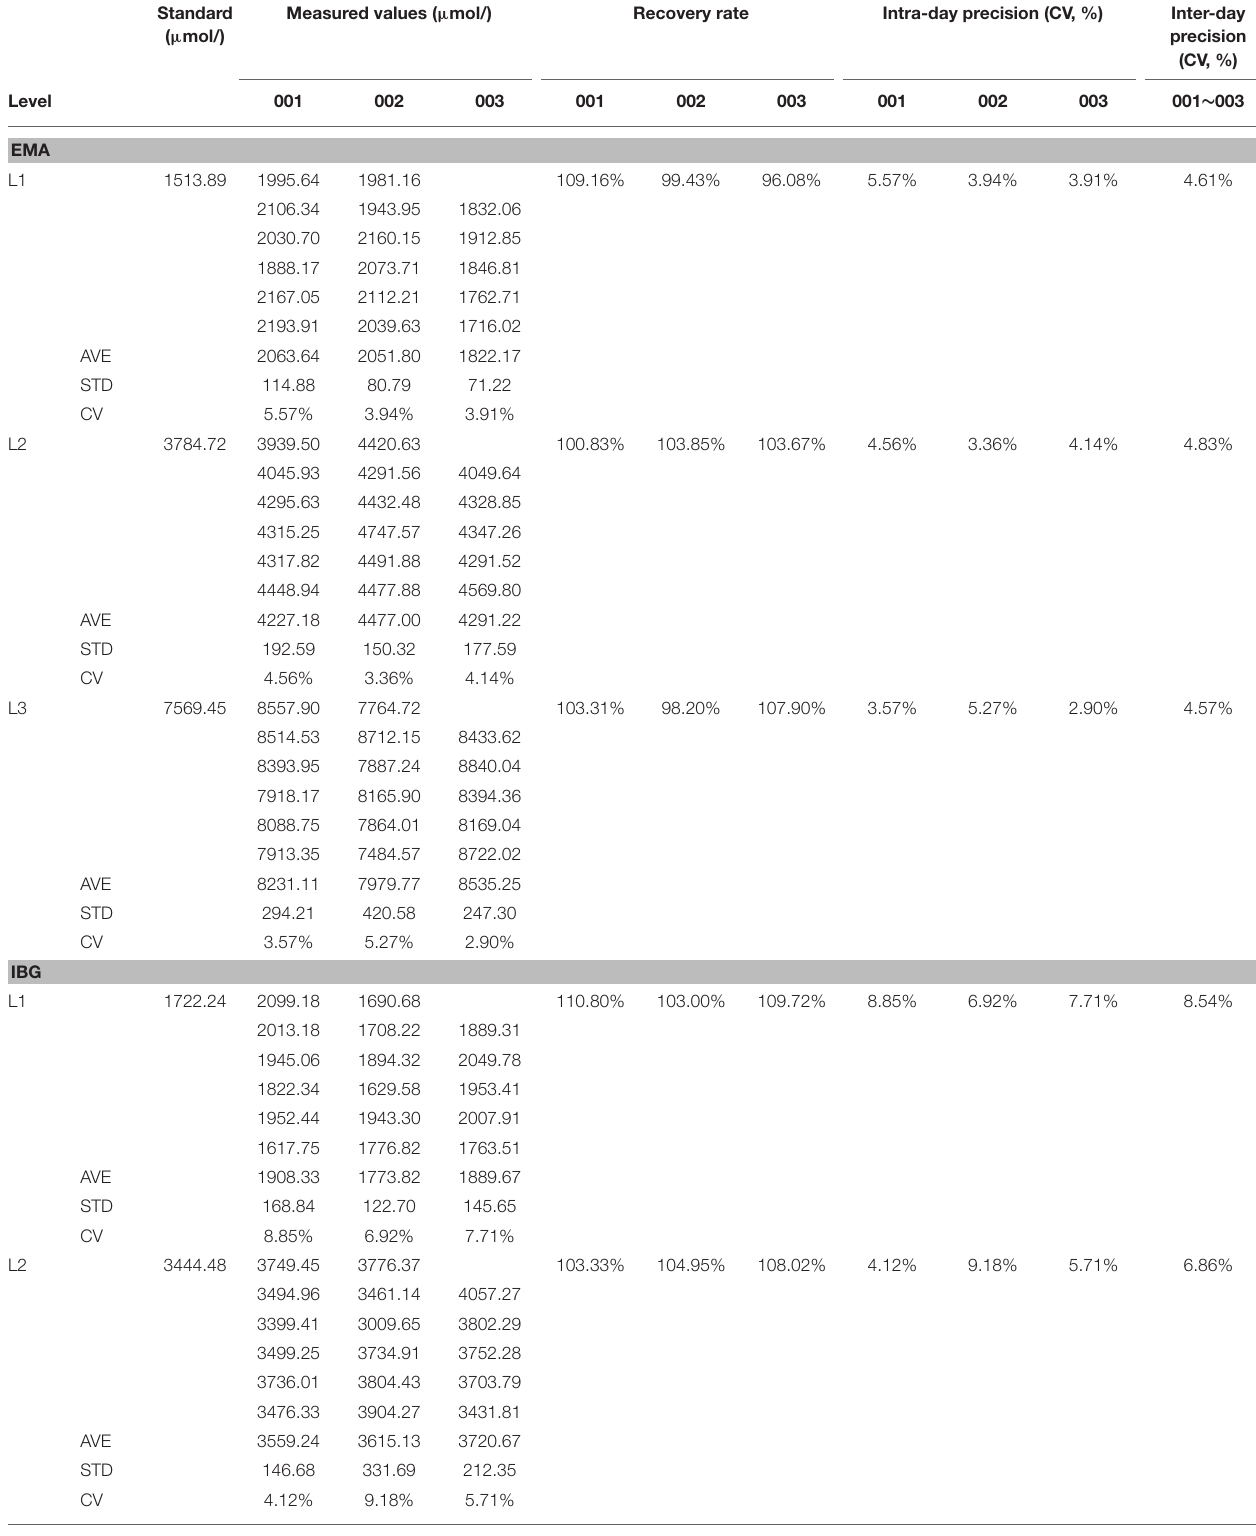
TABLE 4 | The method verification of precision for UPLC-MS/MS to detect the level of isovalerylglycine in dry filter paper. Standard Measured values ( µ mol/) Recovery rate Intra-day precision (CV, %) Inter-day ( µ mol/)